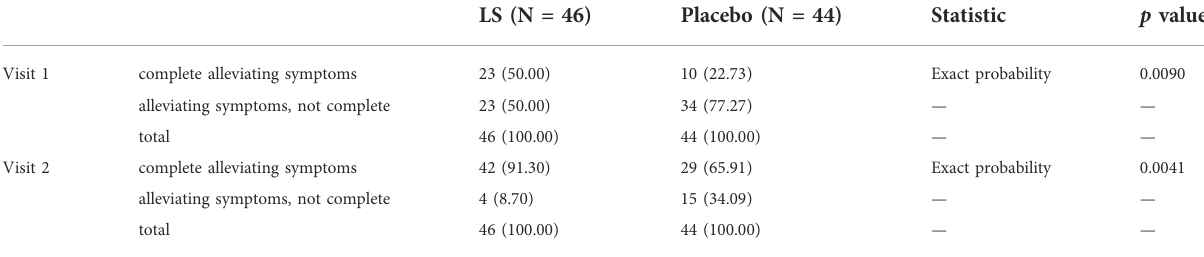
TABLE 6 The rate of number of participants with complete remission of symptoms in LS and Placebo group (FAS).